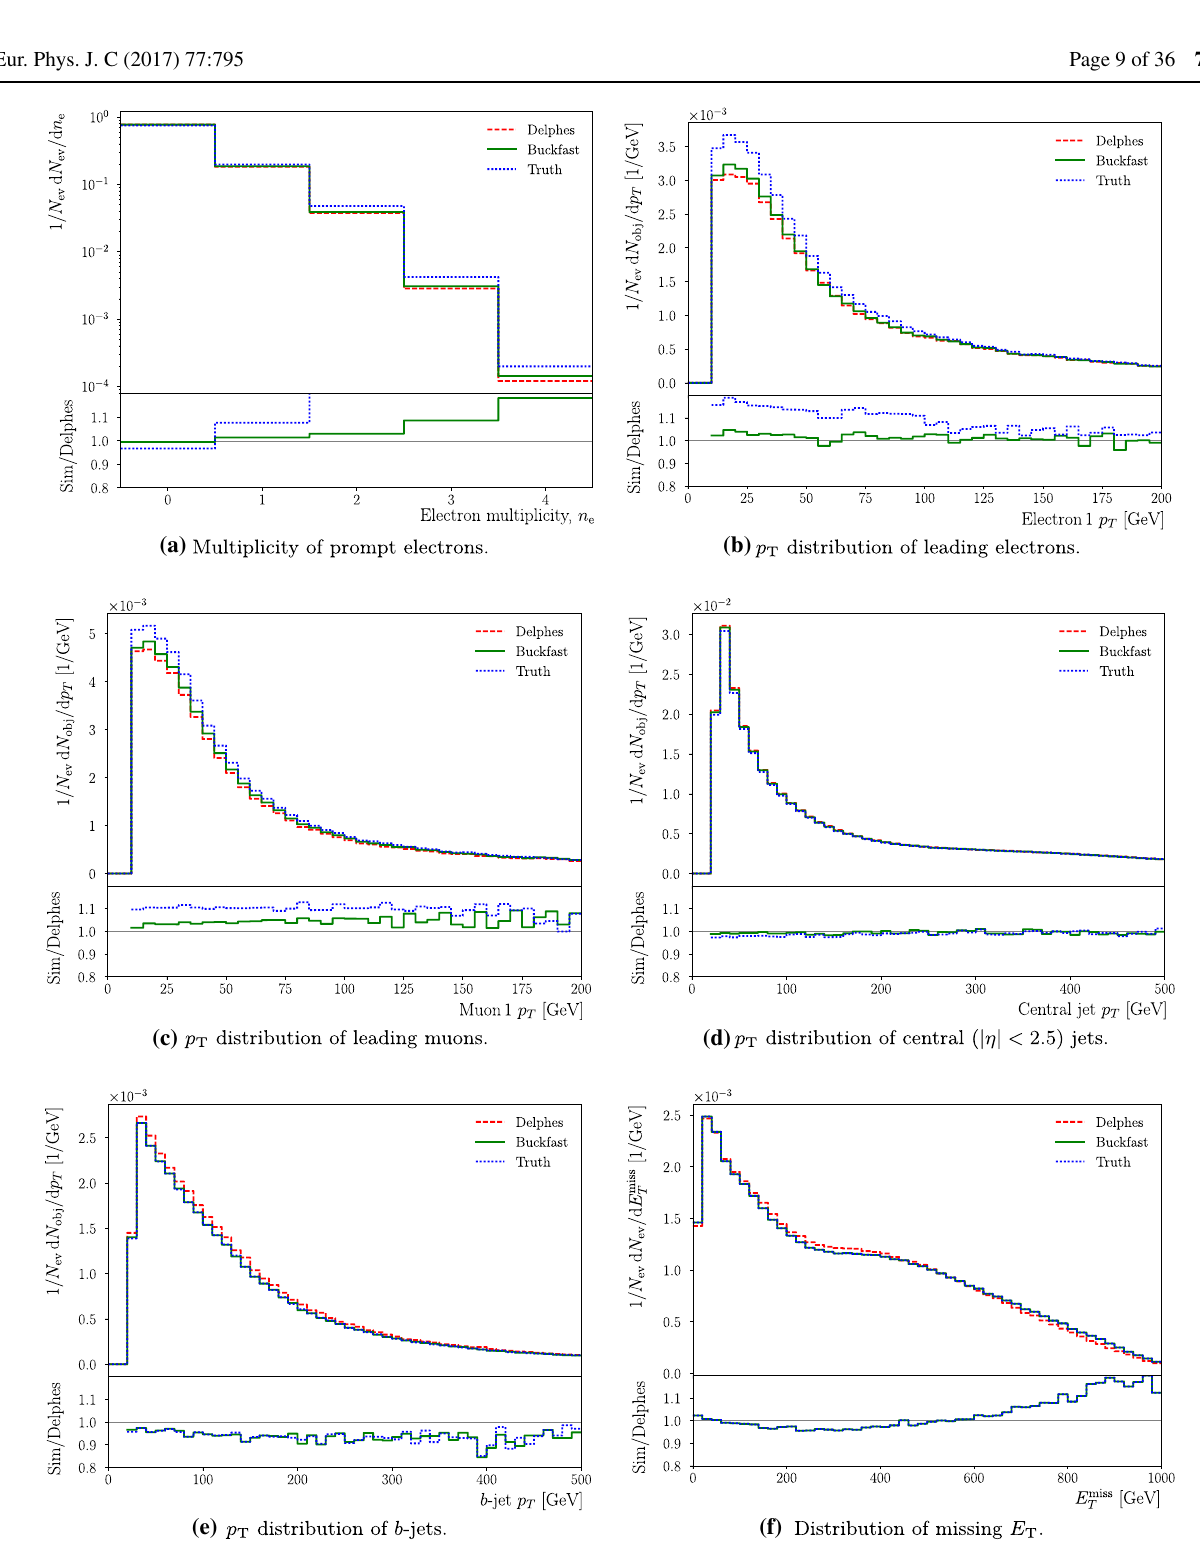
Fig. 2 Comparisons of ATLAS event observables between the no- detector “truth” configuration, ColliderBit ’s BuckFast 4-vector smear- ing simulation, and the Delphes fast simulation code, for a CMSSM